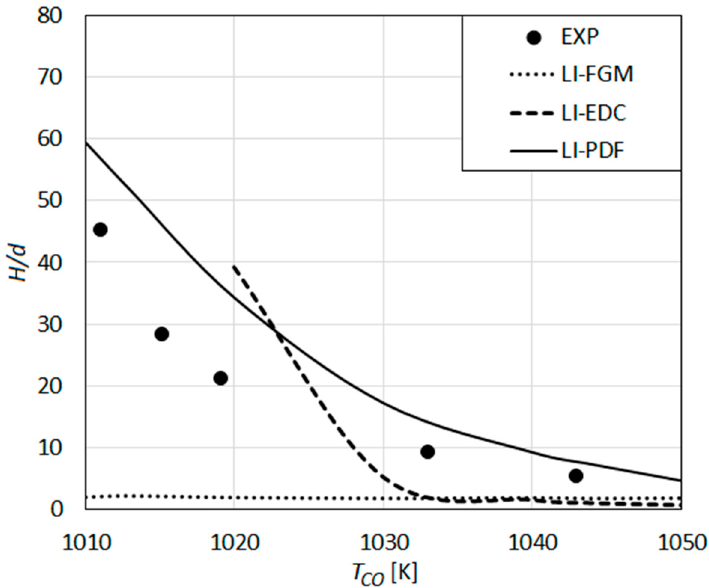
Figure 13. Lift-off height as a function of co-flow temperature: Predictions using the detailed reaction mechanism of Li et al. [33] compared with the measurements of Wu et al. [23].